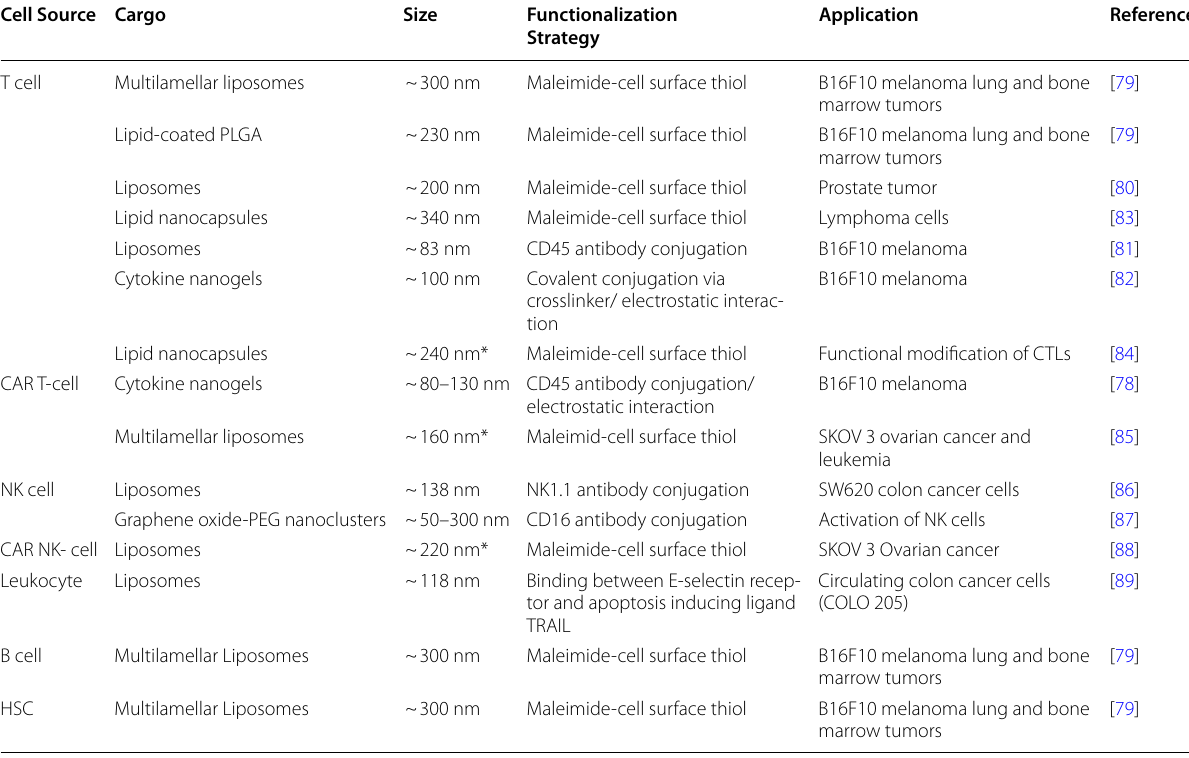
*Size values taken from previously reported literature sources [90,